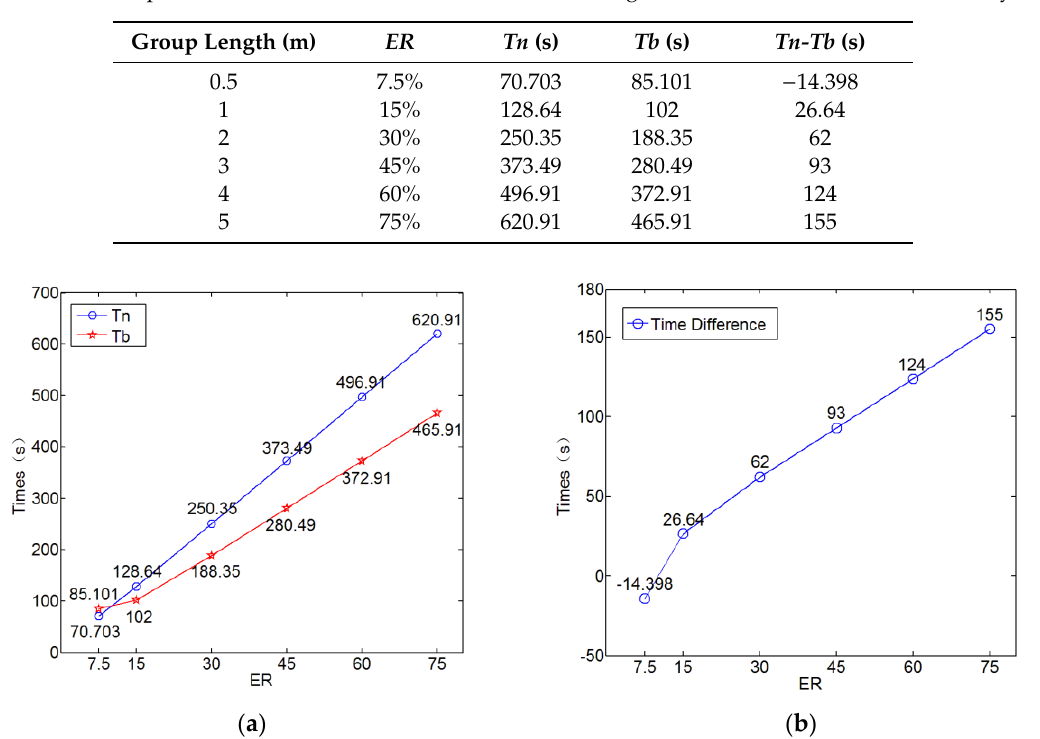
Figure 13. Comparison of the total evacuation time of two strategies under different evacuation